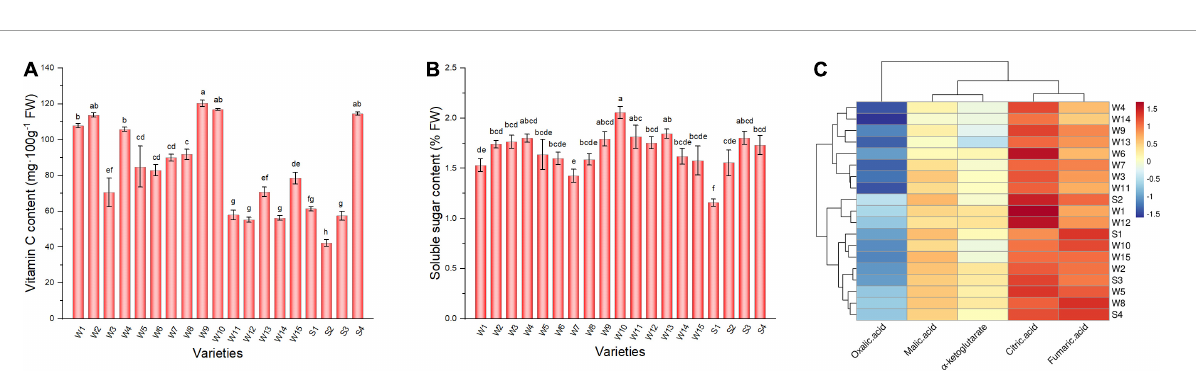
FIGURE4 Vitamin C (A) , soluble sugar (B) , and organic acid composition (C) in peppers. Data in Panels (A,B) are presented as the mean ± SE. Different lowercase letters indicate statistical significance by Duncan’s multiple range test ( p < 0.05). The colored areas in panel (C) correspond to the content of acids from low (blue) to high (red), the data has been log 2 -transformed and standardized. Euclidean distance and average linkage were used to construct the clustering of acids and varieties. W1, Fengshouxianjiao; W2, Sujiao 8; W3, Qingan 7; W4, Sujiao 18; W5, Longjiao 2;